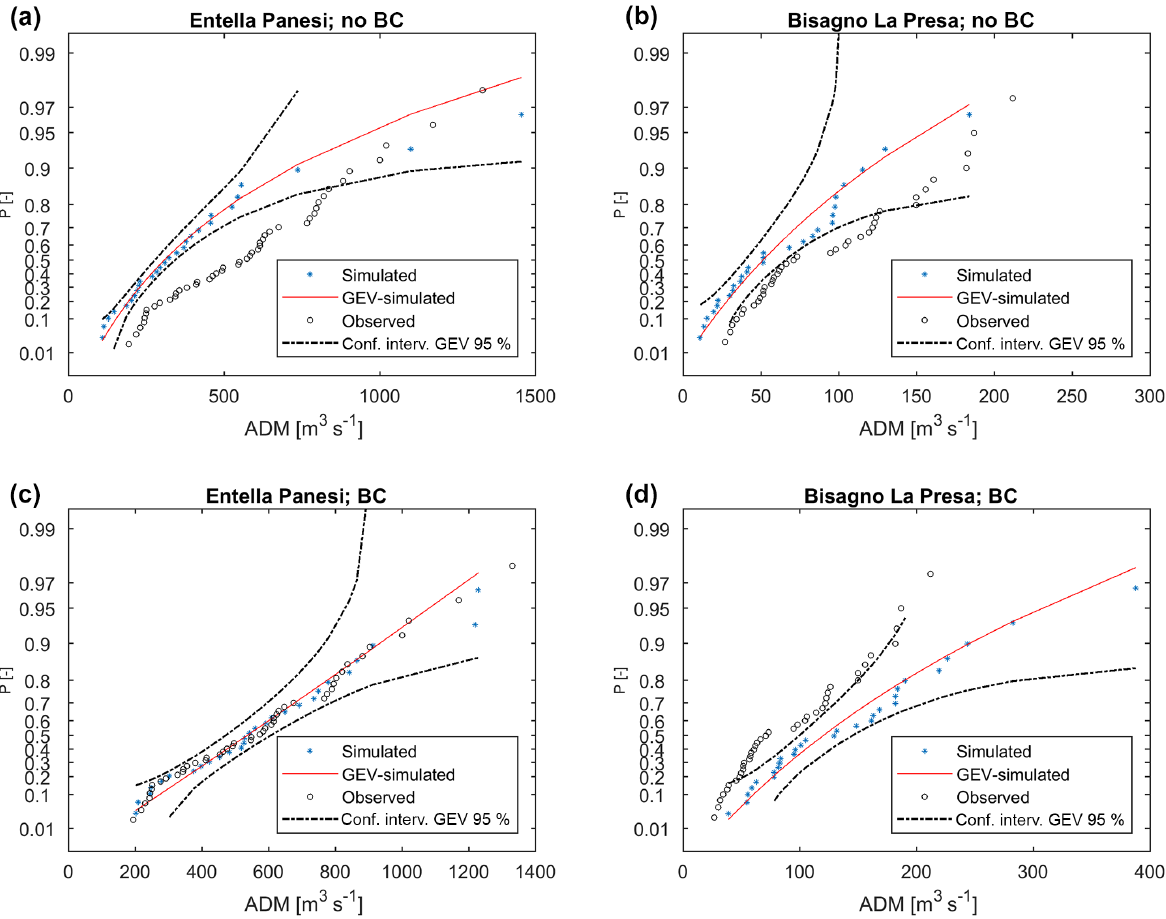
Figure 8. Distribution of ADM for Entella closed at Panesi (364km 2 ) and Bisagno closed at La Presa (34km 2 ). The blue dots are the simulated ADM, black dots are the observed ADM, red line is the GEV fitted on simulated ADM and dotted lines are the confidence intervals with a 95% significance. Panels (a) and (b) show results without rainfall bias correction, while (c) and (d) show results with rainfall bias